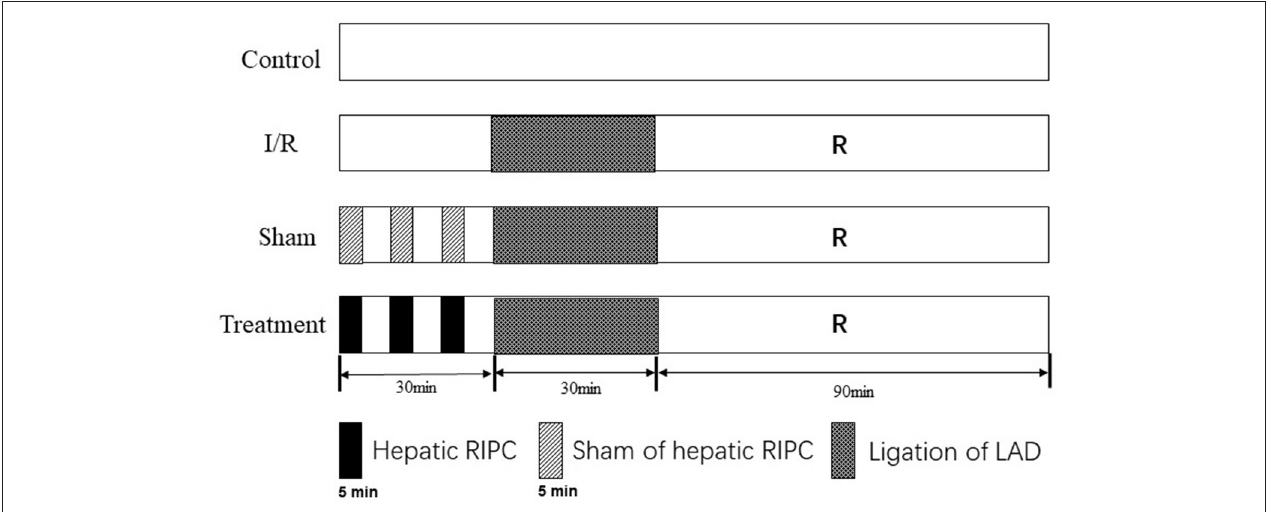
FIGURE 1 | Experimental protocols. The procedure of hepatic RIPC was performed by a three-cycle of 5min before establishing the I/R in the isolated perfused heart. All isolated hearts were subjected to 30-min ligation of the left anterior descending coronary artery, followed by 90 of reperfusion, except for the control group. In the control group, the Langendorff isolated heart perfusion was established in 150min. I/R, ischemia/reperfusion; RIPC, remote ischemic preconditioning.